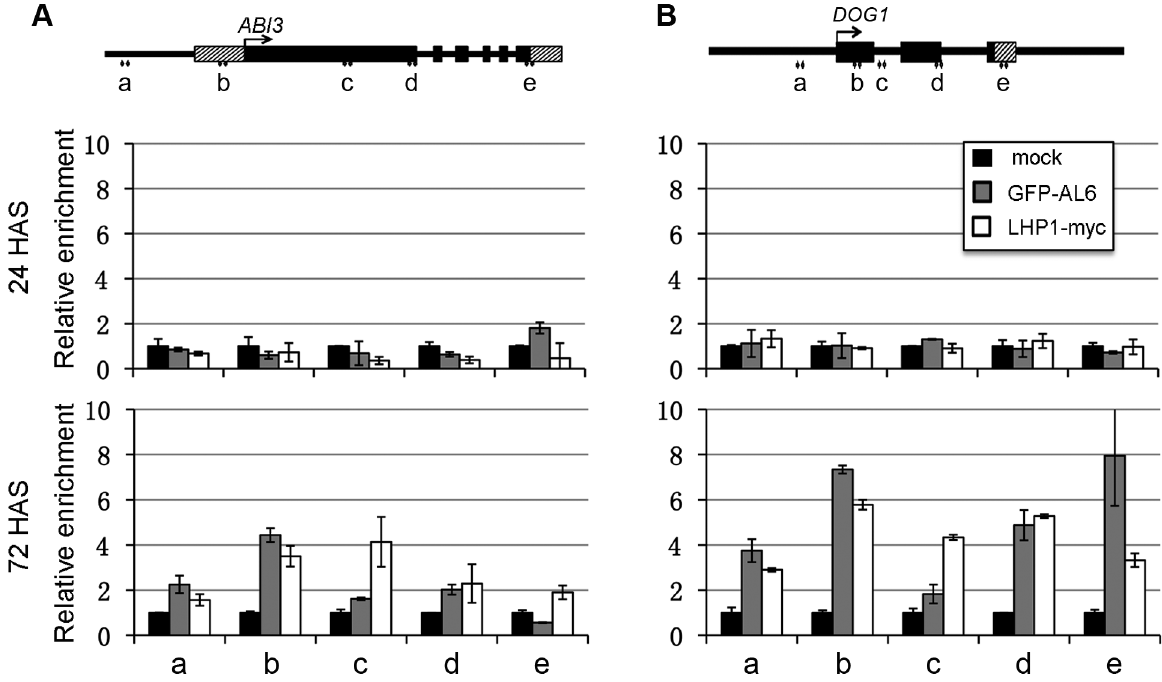
Figure 6. LHP1 and AL6 binding at ABI3 and DOG1 chromatin. Relative enrichments of LHP1-myc and GFP-AL6 proteins were analyzed at the five regions (a to e) of ABI3 (A) and DOG1 (B) loci. Transgenic seeds/seedlings expressing LHP1-myc or GFP-AL6 were analyzed at 24 or 72 hours after stratification (HAS) by ChIP using anti-myc or anti-GFP antibodies. Samples in the absence of antibodies serve as negative controls (mock). Values were normalized to internal controls (relative to input and to TUB2 ). Data represent means 6 SD of three biological